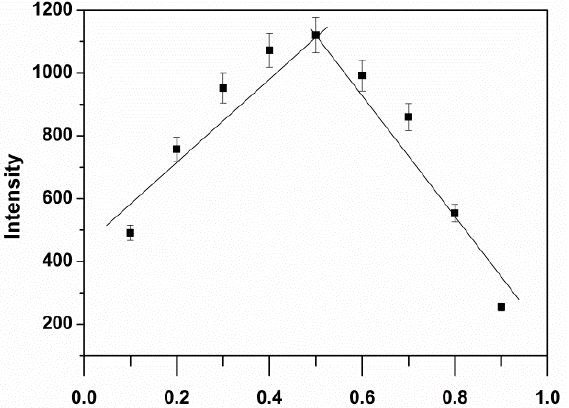
Figure 4. Stoichiometry for P and Cu 2+ by Job’s plot in alcohol – aqueous media ( v / v , 8:2, pH 6.3, 0.02 M HEPES). The total concentration of ([P] + [Cu 2+ ]) was 10